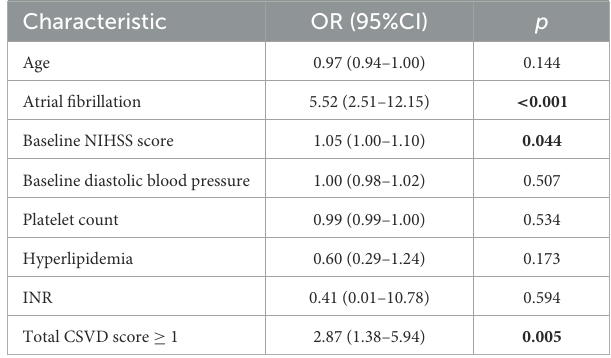
TABLE 3 Regression analysis to identify associations of clinicodemographic characteristics with risk of hemorrhagic transformation after intravenous thrombolysis a